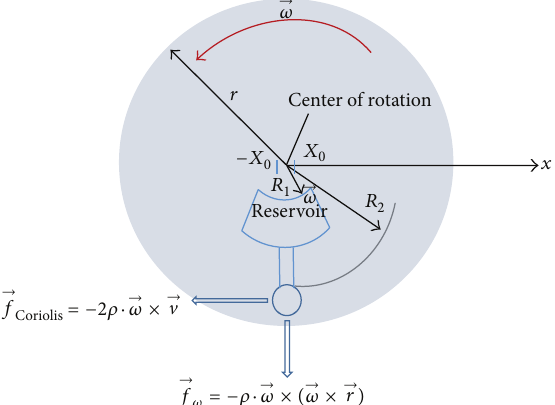
Figure 1: The width of the channel is Δ𝑥 = 2𝑥 0 , and 𝑅 1 and 𝑅 2 are the boundaries of a liquid element corresponding to its distances from the center of the CD. When CD spinning at induces the radial centrifugal force and transversal Coriolis force with respect to the flow velocity and the mass density of the liquid 𝜌